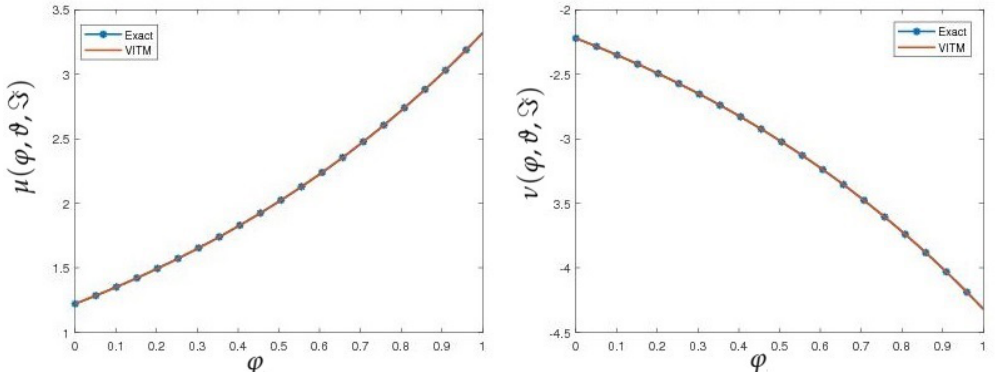
Figure 9. The exact and approximate solution graphs of µ ( ϕ , ϑ ) and ν ( ϕ , ϑ ) , Example 1.